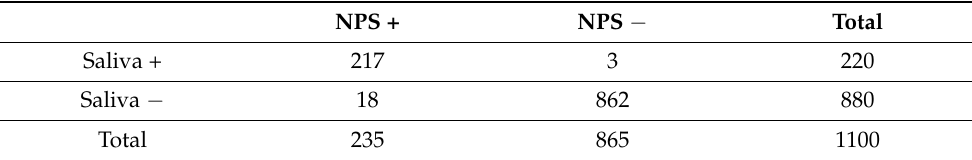
Figure A1. Excerpt from instruction leaflet for saliva collection. Participants were asked to clear their throat and collect approximately 0.5–1 mL saliva into a collection tube ( A ). Virus transport medium (VTM) was added to the crude saliva immediately after collection ( B ), and the content was mixed through gentle tilting ( C ). Table A1. Contingency Table: